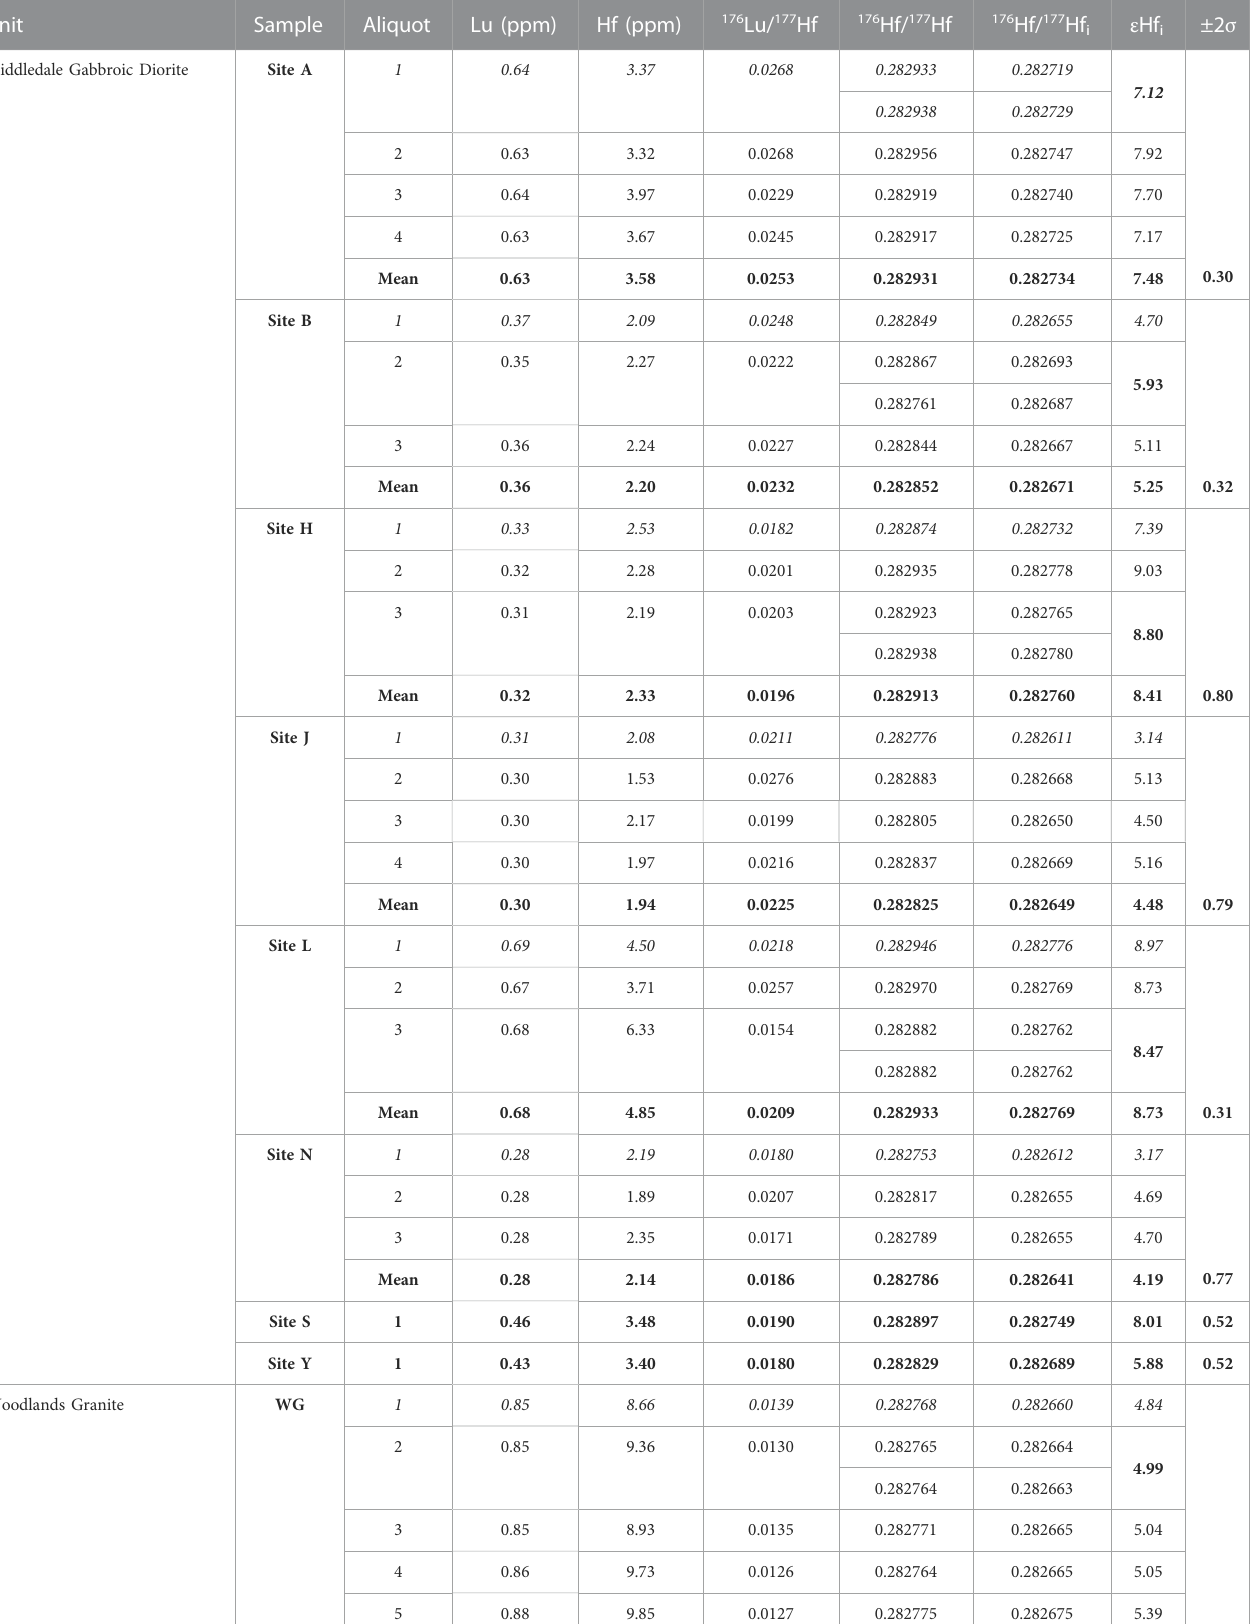
TABLE 2 Wallundry Suite Lu-Hf data acquired by MC-ICPMS. Samples have been age corrected to 416.8 (Black et al., 2004; Iles, 2012). The ε Hf i values have been calculated using the modern CHUR values 176 Lu/ 177 Hf = 0.0336 and 176 Hf/ 177 Hf = 0.282785 of Bouvier et al. (2008). Values in italics are data derived from a trace element runofseparatealiquots,pairedwith 176 Hf/ 177 Hfdeterminationsmadewithouttheuseofanisotopespike.Whererepeatanalysesweremadeofanaliquot,bothisotope ratio determinationsarereported,butonly theaverage ε Hf i value forthe aliquotisshown. Representative values(singleanalysis ormeanof analyses) foreachsample are shown in bold.